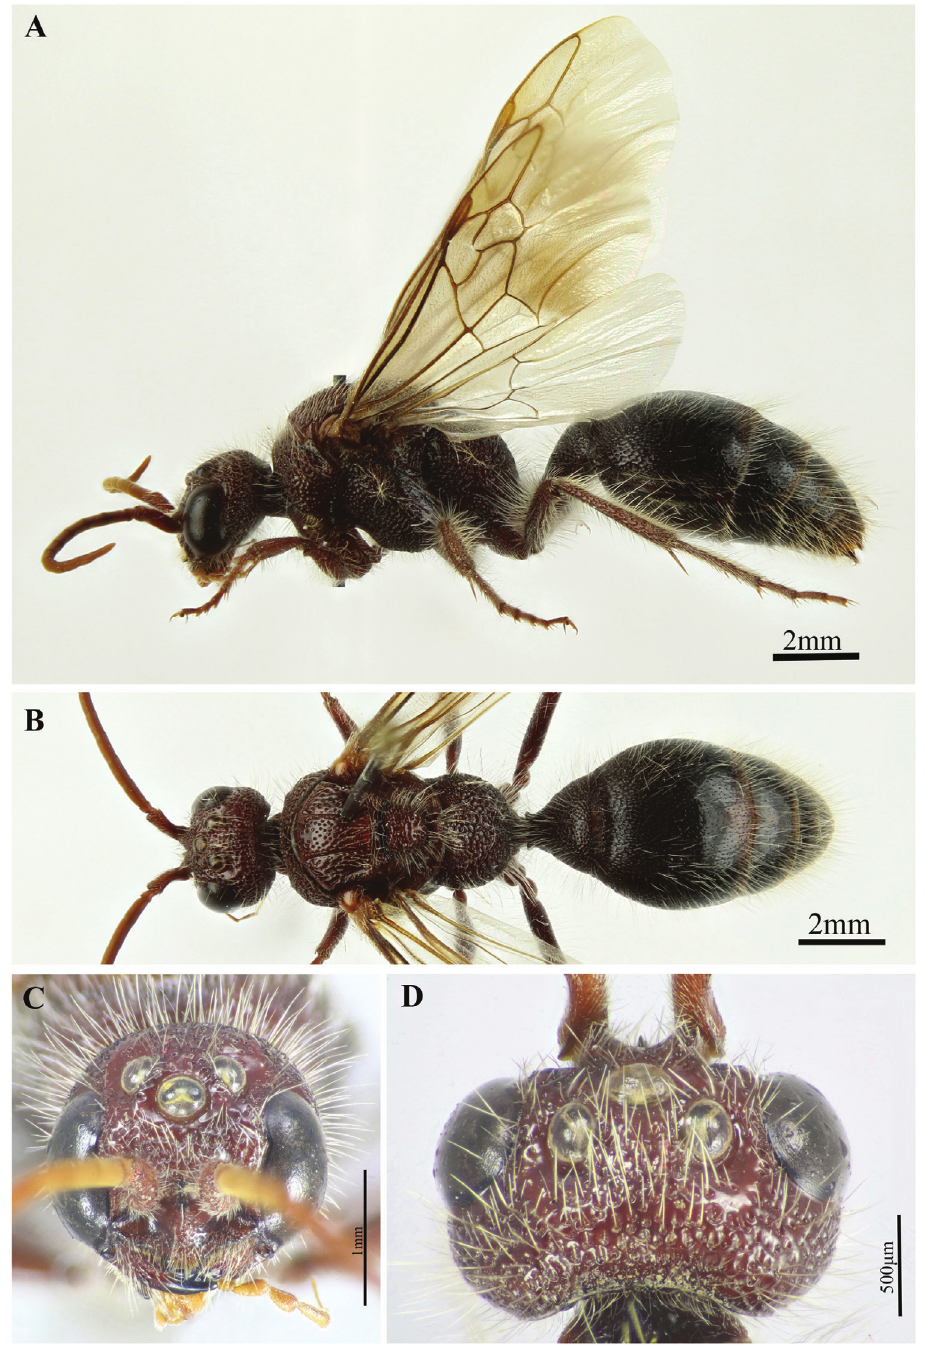
Figure 23. Pseudophotopsis maura Bischoff (Male) A, B habitus, lateral and dorsal views, respectively C, D head, frontal and dorsal views,